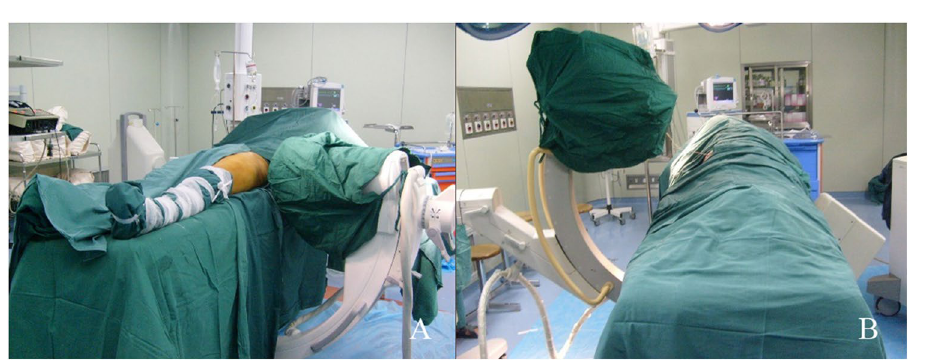
Figure 3. ( A ) The C-arm fluoroscope unit was positioned for the lateral view of the sacrum. ( B ) The angle of the C-arm was fixed to make it project along the axial view of the pedicle of the first sacral vertebra.